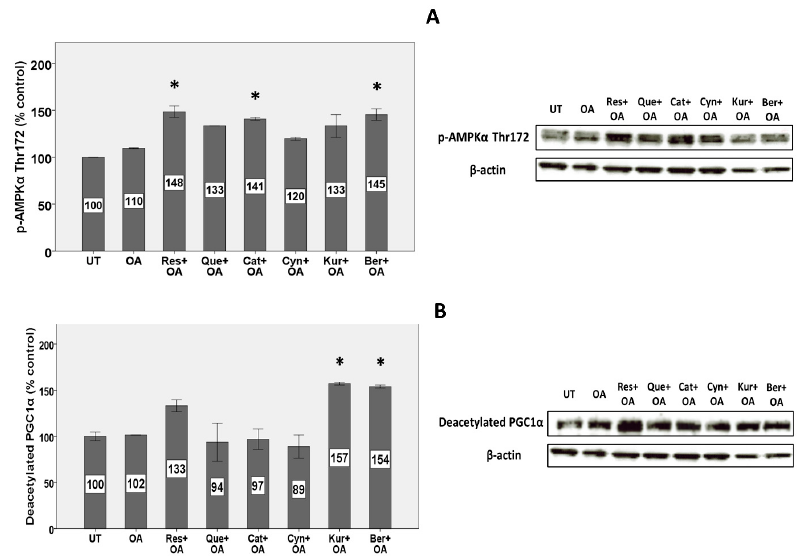
Figure 4. Effects on protein expression of ( A ) p-AMPK α Thr172 and ( B ) deacetylated PGC1 α . HepG2 cells were treated with 10 µ M polyphenols for 2 h and 1.5 mM OA for 24 h, and protein levels were measured by Western blot ( n = 3). Untreated cells were set at 100% and data are presented as % of the untreated cells. β -actin was used as an internal control. (*) Significantly different ( p < 0.05) from the OA alone condition.